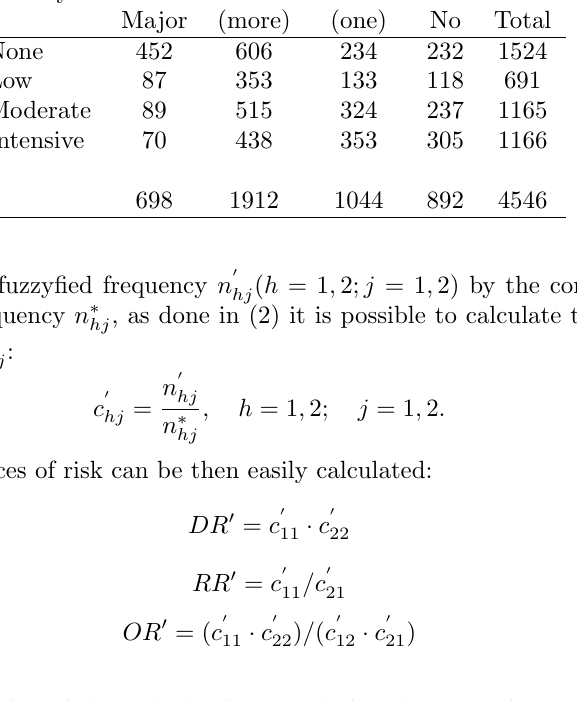
Physical activity and perceived health problems in people over 65 Level